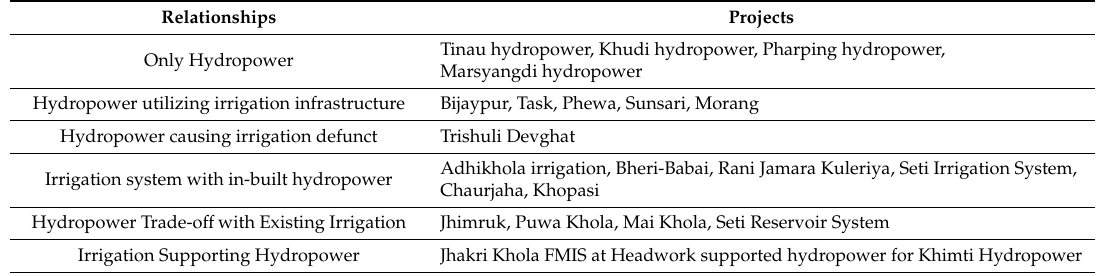
Table 3. Various relationships between hydropower and irrigation projects in Nepal. Relationships